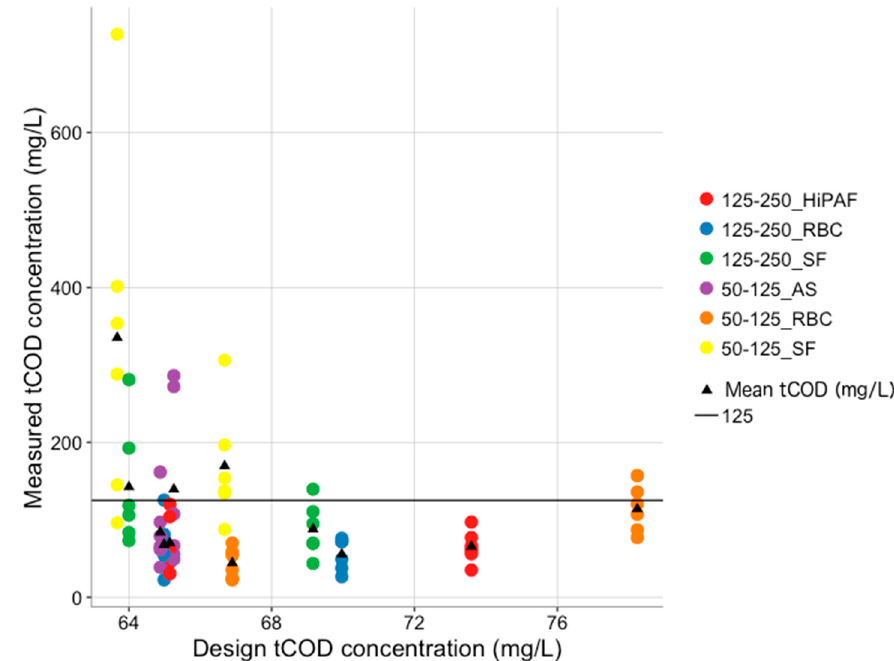
Figure 3. Mean design and mean measured final effluent concentrations of tCOD for each study site and each experimental design category for small WWTP only. Black line denotes the UWWTD regulatory discharge limit of 125 mg/L COD. Black triangles denote mean measured effluent tCOD values for each site. N = 90.